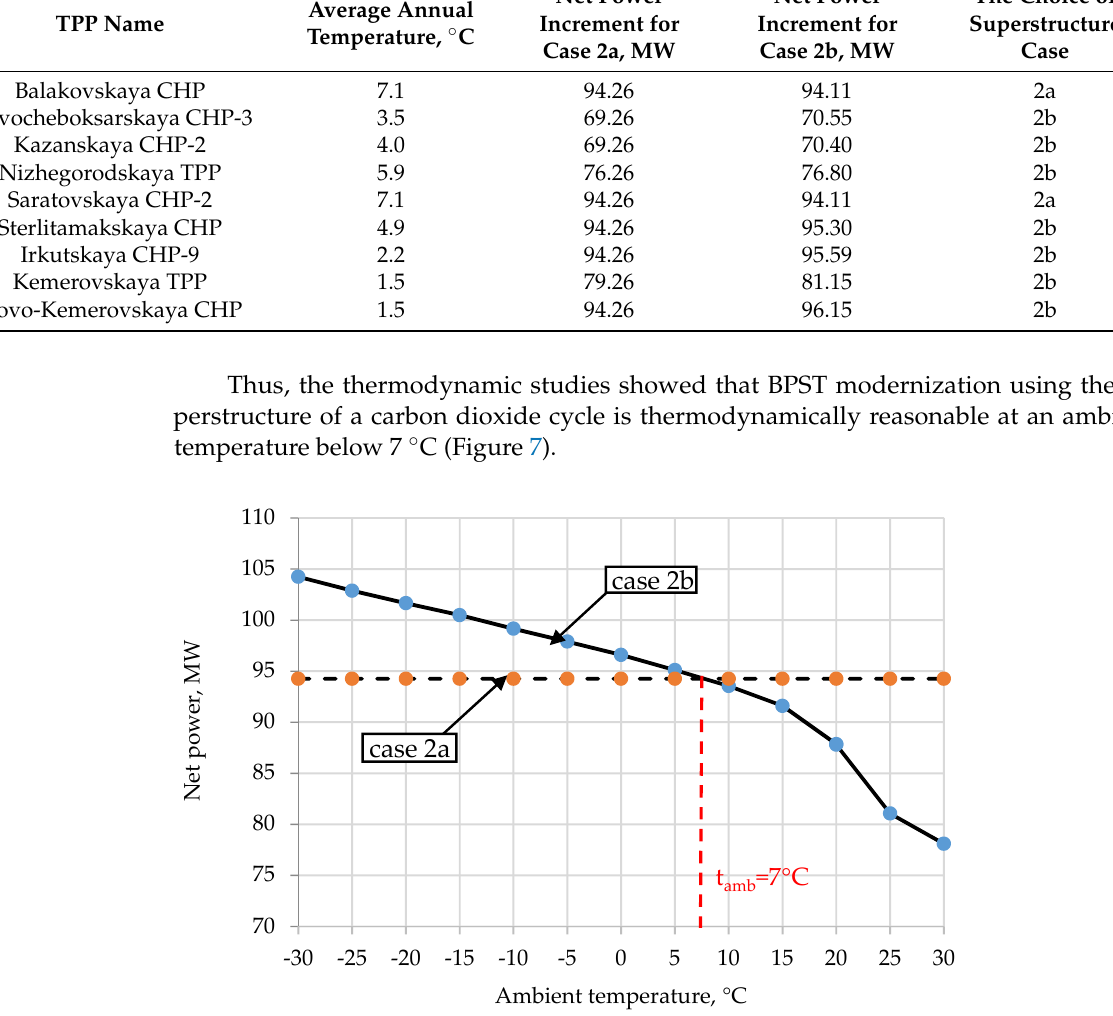
Figure 8. The location scheme for the modified TPPs with BPSTs in Russia. Blue point—for case 2a; red point—for case 2b. Thus, the modernization method for a BPST by the superstructure of a carbon dioxide power cycle proposed in this work is advisable to use for seven of nine underloaded TPPs. The total increase in the net power for this case is 585.9 MW. In turn, the LPT superstruc- ture is expedient for two of nine TPPs: the total increase in the net power, in this case, is 188.5 MW. It is important to note that the implementation of the described modernization meth- ods will provide not only a significant increase in TPP energy efficiency but also contrib- ute to the average reduction in specific CO 2 emissions. This effect is since the additional power is produced at the expense of the utilization of useless low-potential heat without an increase in fuel consumption.